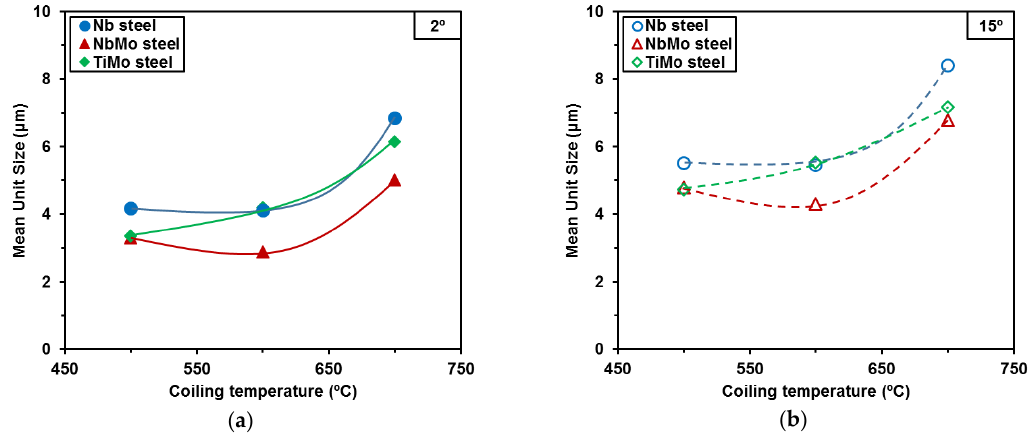
Figure 3. Influence of coiling temperature and chemical composition on the average unit size, using different threshold misorientation criteria: ( a ) low angle (2°); and ( b ) high angle (15°) boundaries.